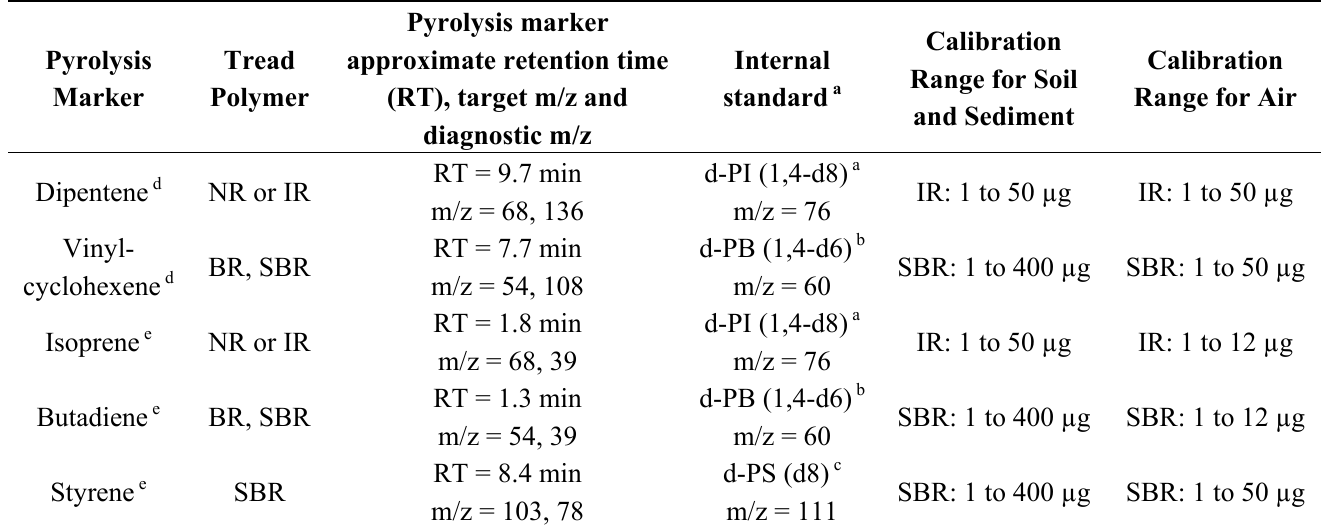
Table 3. Pyr-GC/MS markers and internal standards for soil, sediment and